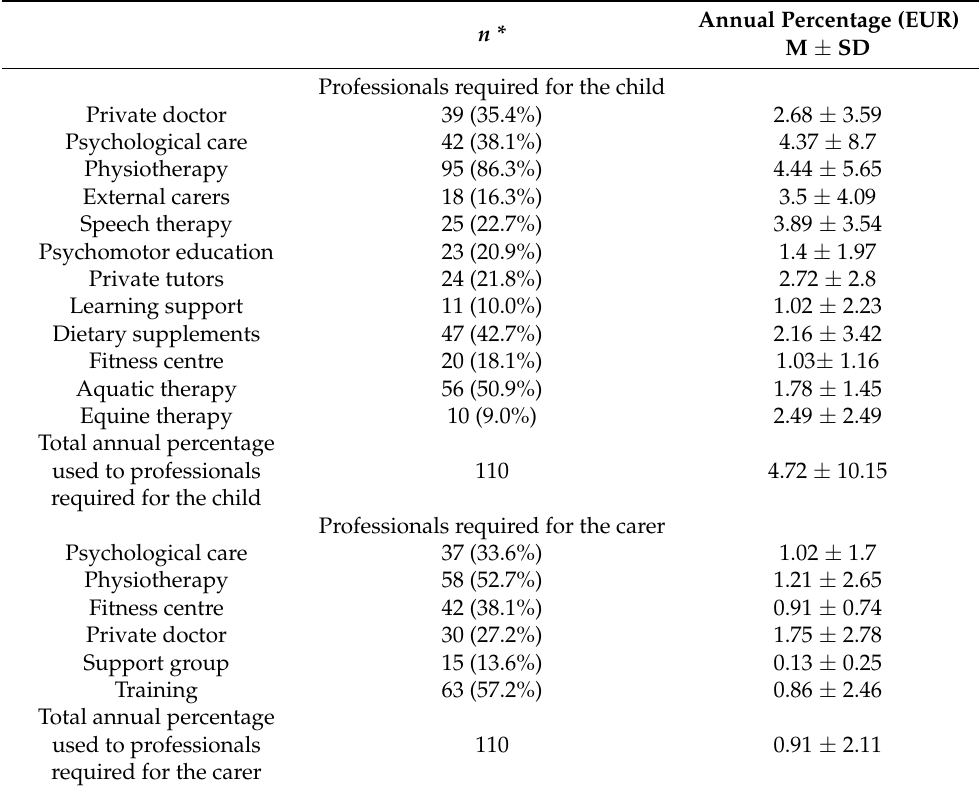
Table 3. Annual percentage of annual income used to cover health-related costs by caregivers. ( n = 110).